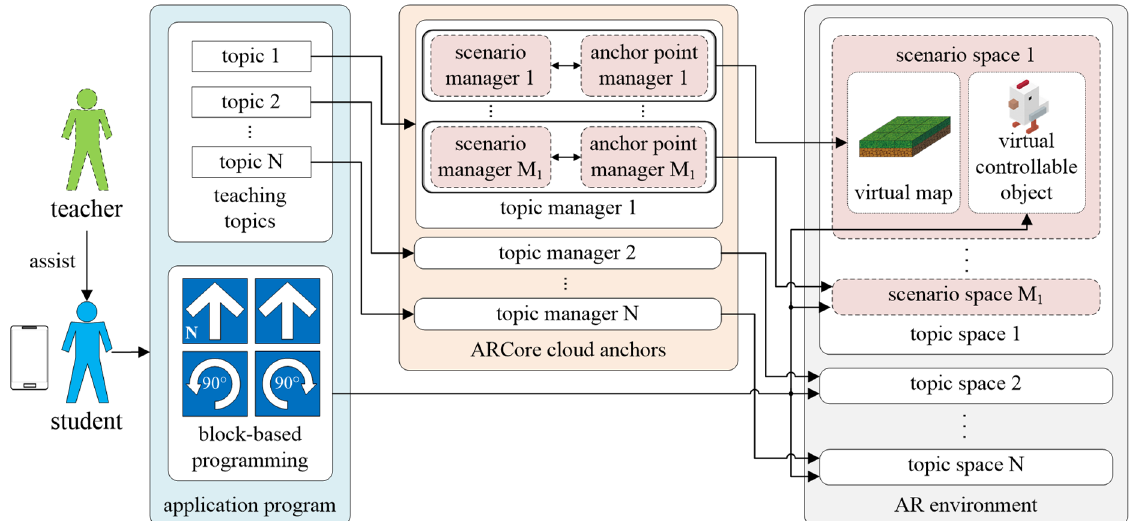
Figure 2. Architecture of the proposed teaching system, which comprises three parts: the application program, ARCore cloud anchors, and AR environment. The application program contains multiple teaching topics, each of which is implemented by the AR-based teaching content in the system. The ARCore cloud anchor module contains the same number of topic managers as topics. Each topic manager has multiple scene managers and anchor managers to store virtual contents and the corresponding anchor positions, respectively. The AR environment is composed of multiple topic spaces, each of which comprises multiple scenario spaces related to learning topics.